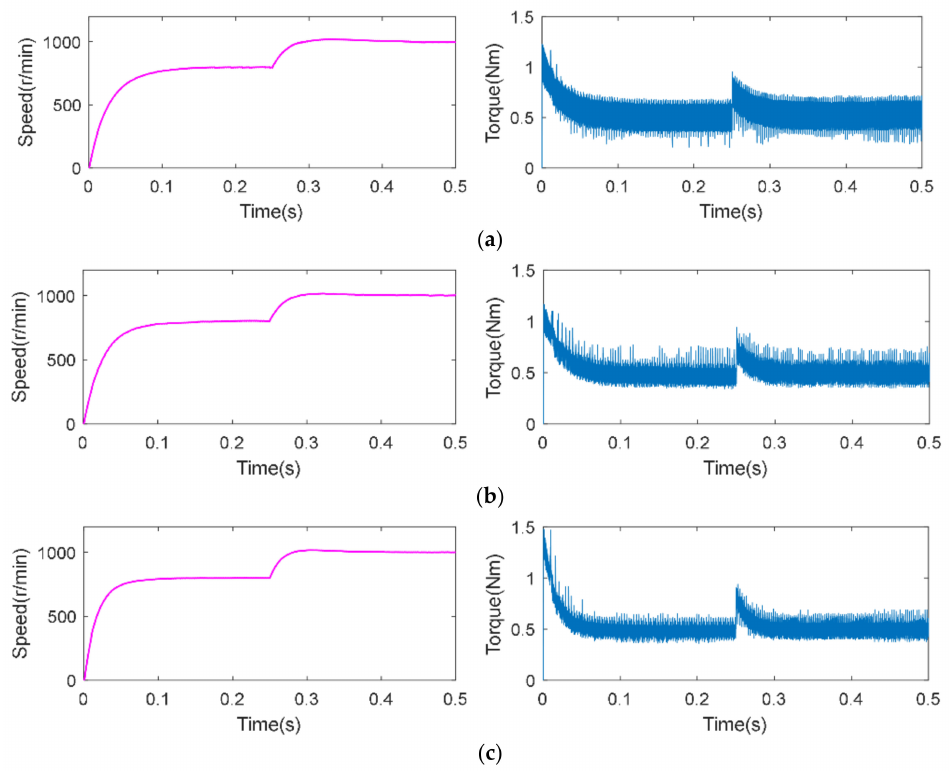
Figure 9. Speed and torque under 1000 r/min and 0.4 Nm. ( a ) Method 1, ( b ) method 2, and ( c ) method 3.